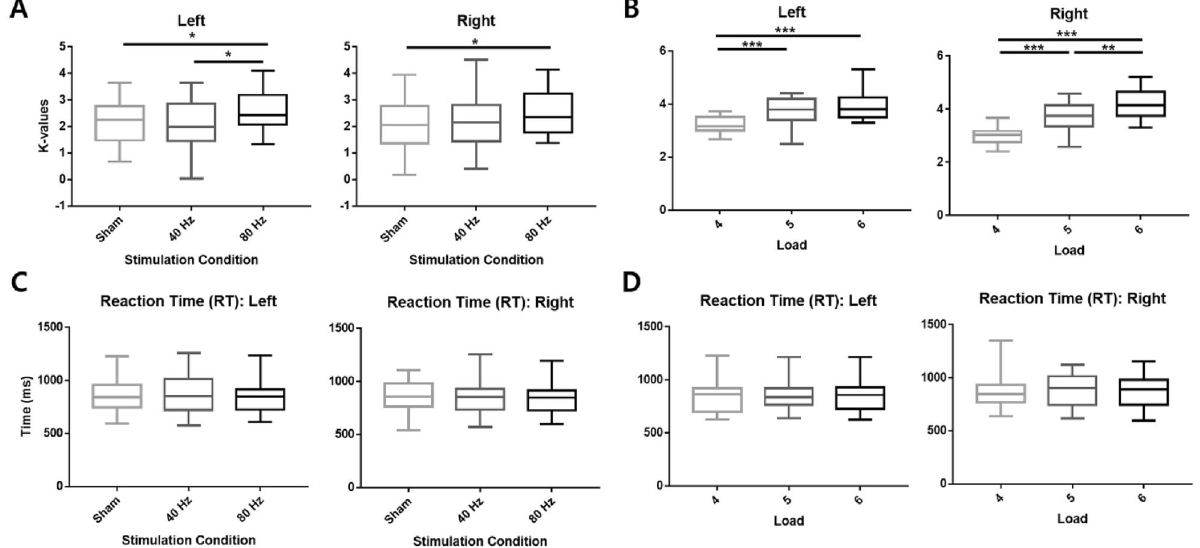
Figure 6. The behavioral performances under each stimulation condition. K-value and reaction time changes for the factors, condition and load. ( A ) Change of the K-values relative to the factor, condition, ( B ) change of the K-values relative to the factor, load, ( C ) change of the reaction time relative to the factor, condition, and ( D ) change of the reaction time relative to the factor, condition. K-values of both visual hemifields were affected by the factor, condition, increasing under 80 Hz stimulation compared to sham. The K-values also increased as the load increased, which again emphasizes that K-values are a quantitative representation of the factor, load. The reaction time was not affected by either condition or load. * p < 0.05; ** p < 0.01; *** p < 0.001. All p-values are corrected values using FDR.